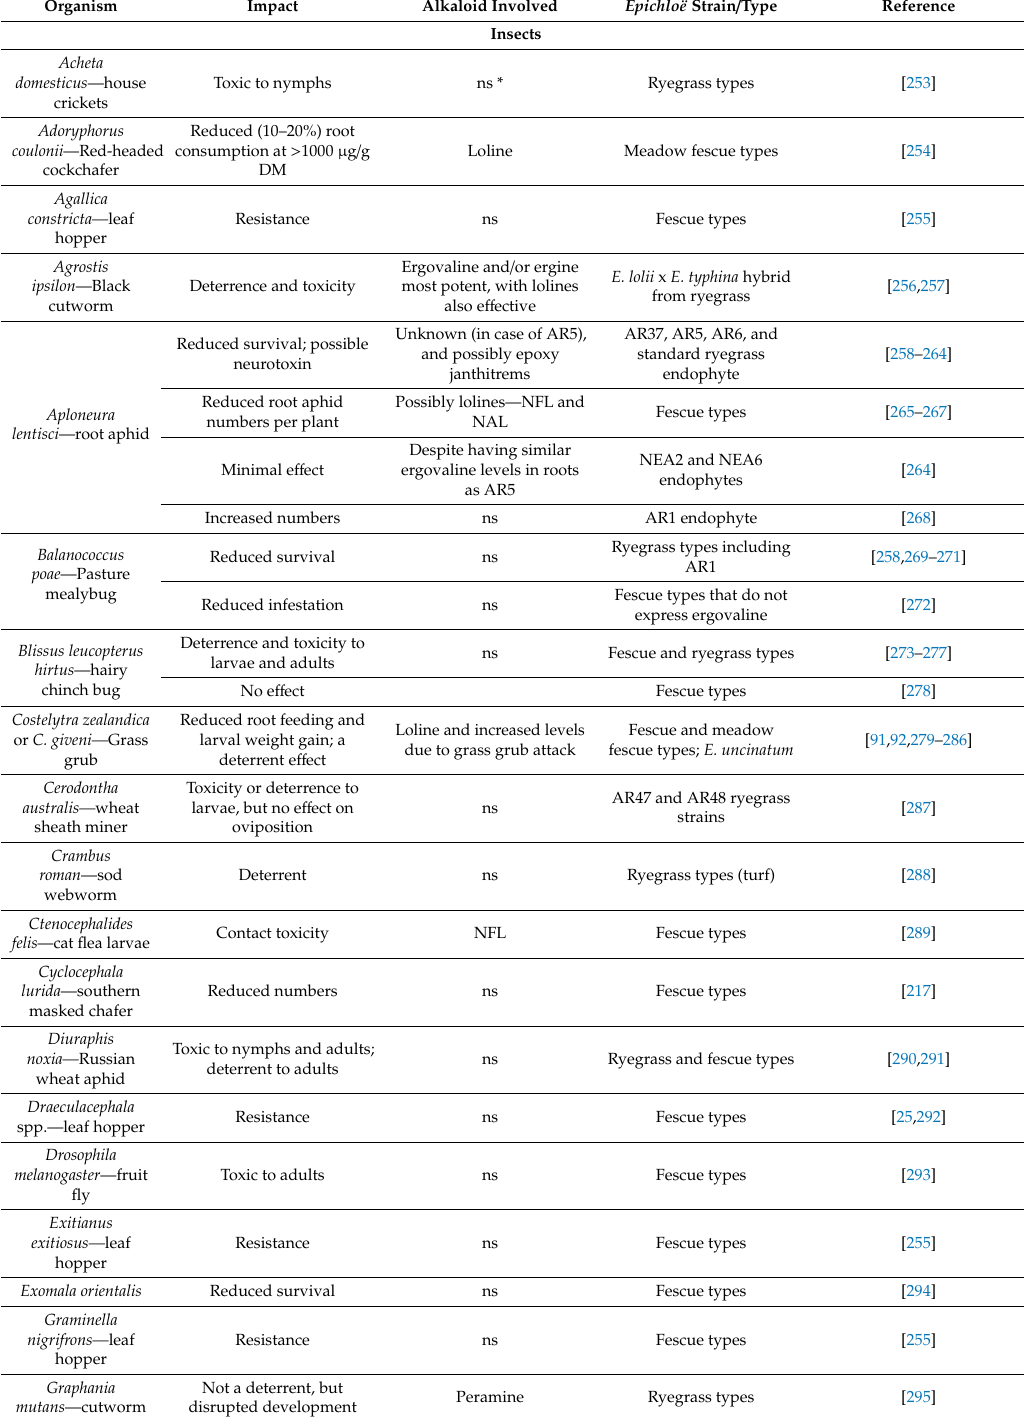
Table 4. Invertebrate organisms (insects, nematodes and molluscs) impacted by Epichloë endophytes; for other older references related to e ff ects of Epichloë endophytes in ryegrass and tall fescue on insects, refer to Breen (1994)